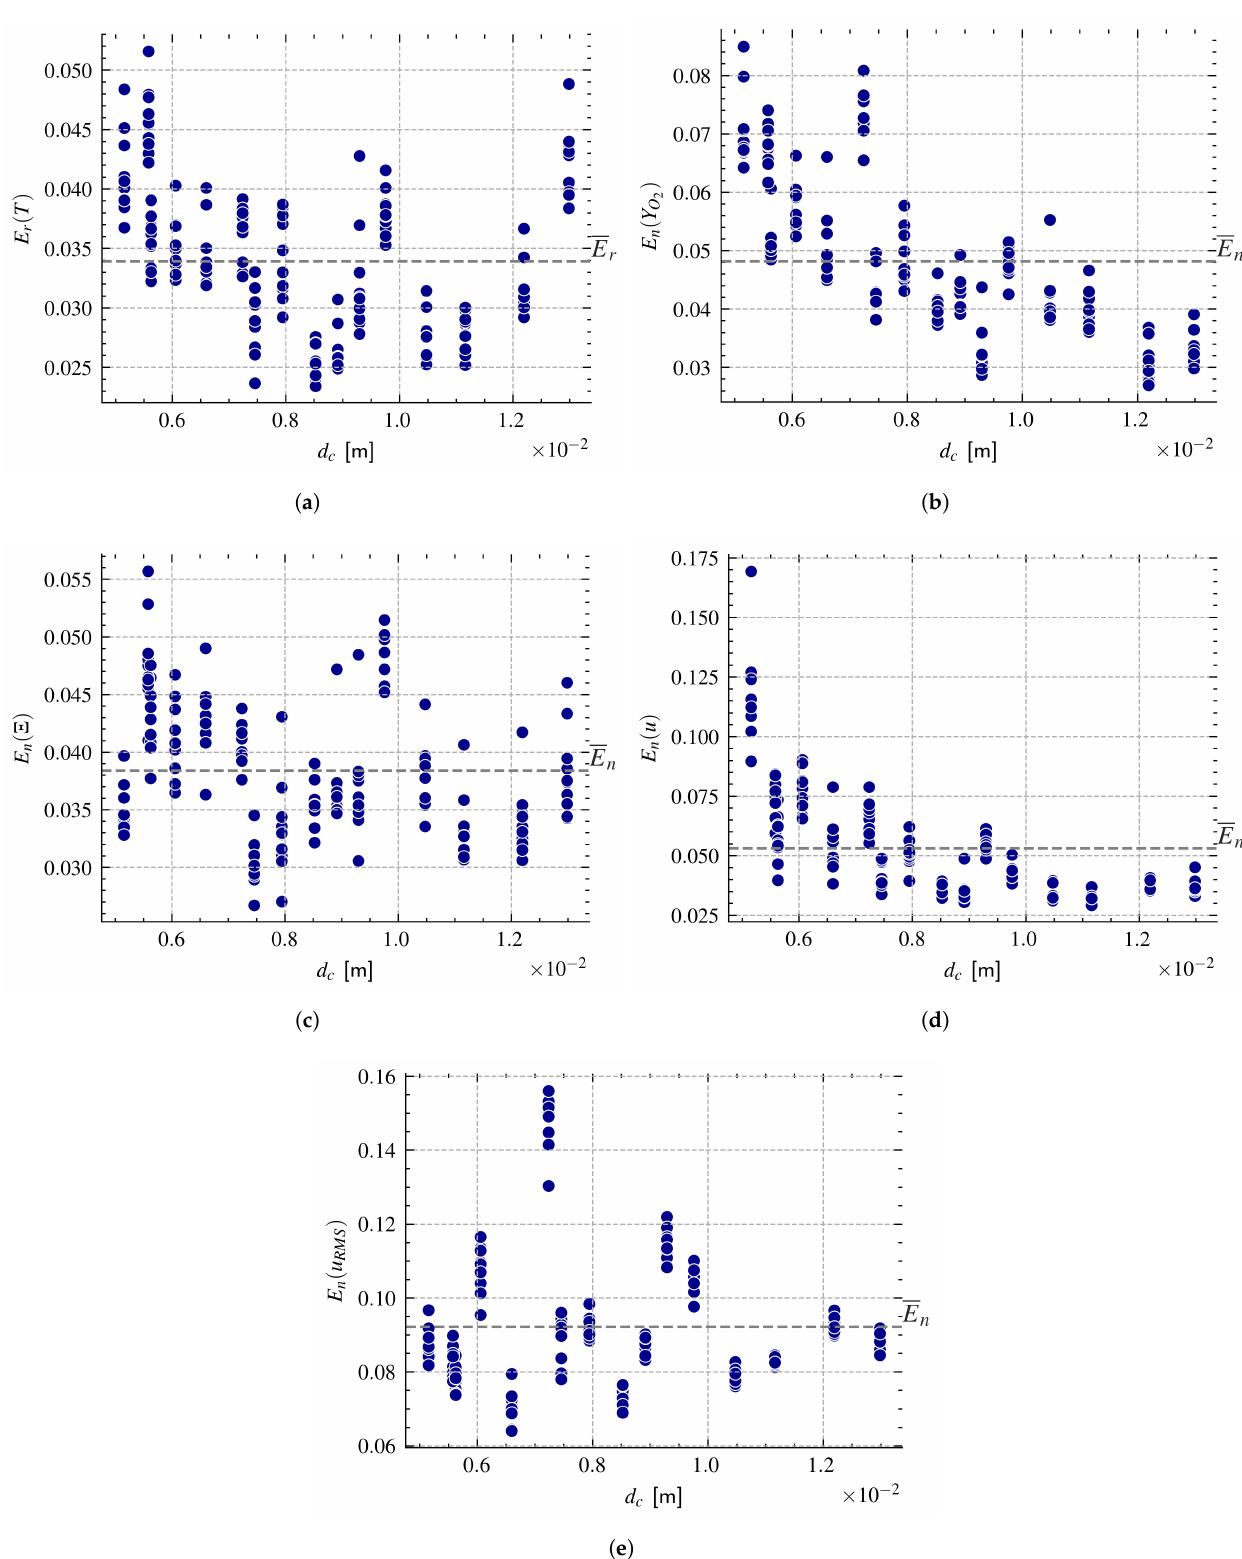
Figure 7. Scatter plot of the relative errors of the best-performing networks, for every fold and sample of DS2, as a function of the sample’s d c coordinate for each of the field quantities: ( a ) T , ( b ) Y O ( d ) u , and ( e ) u RMS . The average error across samples and folds is highlighted in gray for every